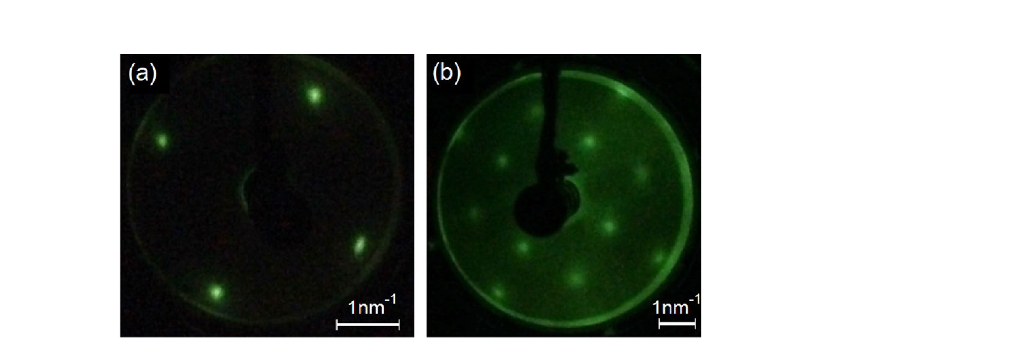
Figure 2. ( a ) AFM image (2.5 × 2.5 µ m Ni 1 − x Li x O (001) surface. The domains are around 100 nm and several nanometers in size in AFM and STM images, respectively.